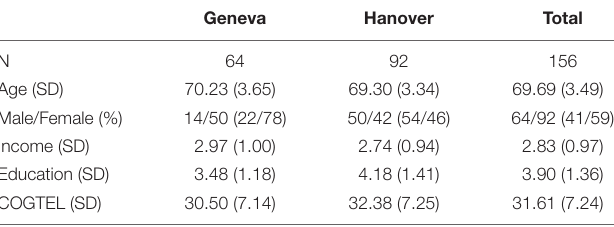
TABLE 1 | Demographic information of the